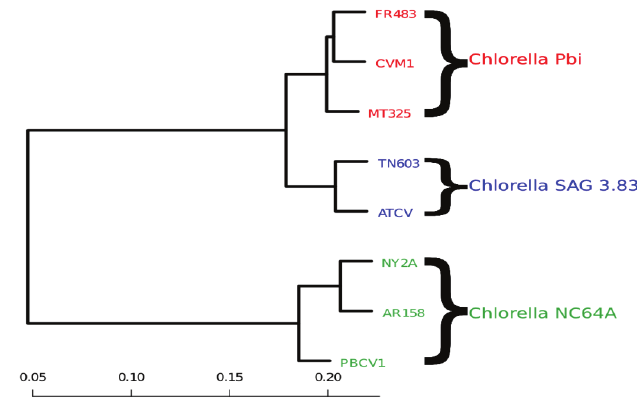
Figure 3. Clustering of viral genomes, annotated by their respective hosts—in this case variants of the Chlorella algae. The branch lengths are proportional to the phylogenetic Jensen-Shannon distance of Equation (4), the scale is indicated at the